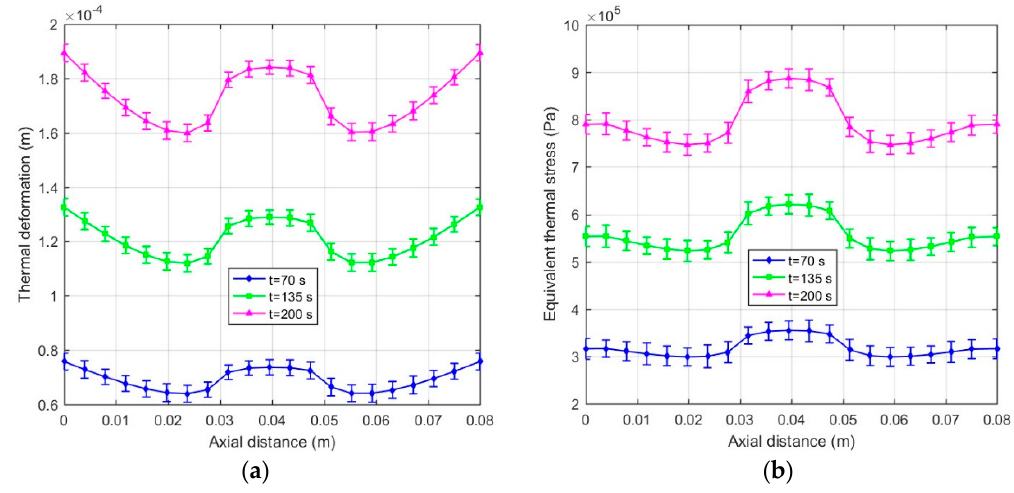
Figure 13. Thermal deformation and equivalent thermal stress of MRFs of the cylinder ‐ type MRC along axial working gap: ( a ) Thermal deformation; ( b ) Equivalent thermal stress.